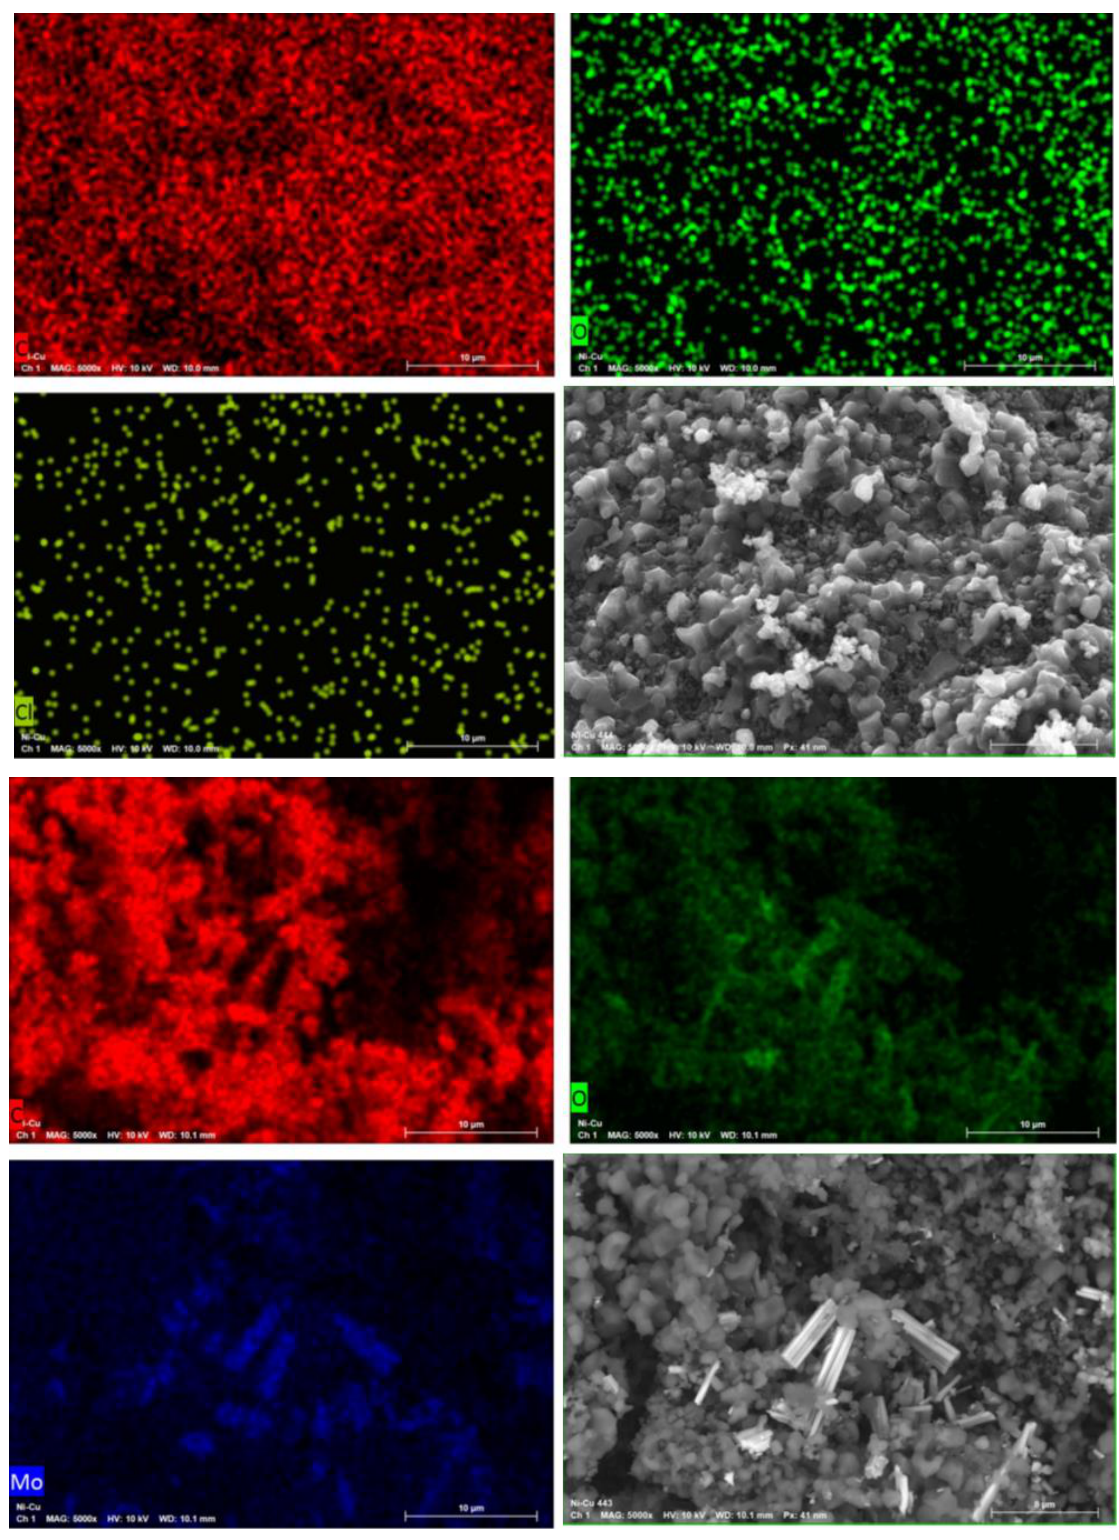
Figure 7. SEM elemental mapping of CDC before and after the adsorption of Mo. The corresponding functional groups on the CDC were determined by FTIR analysis.